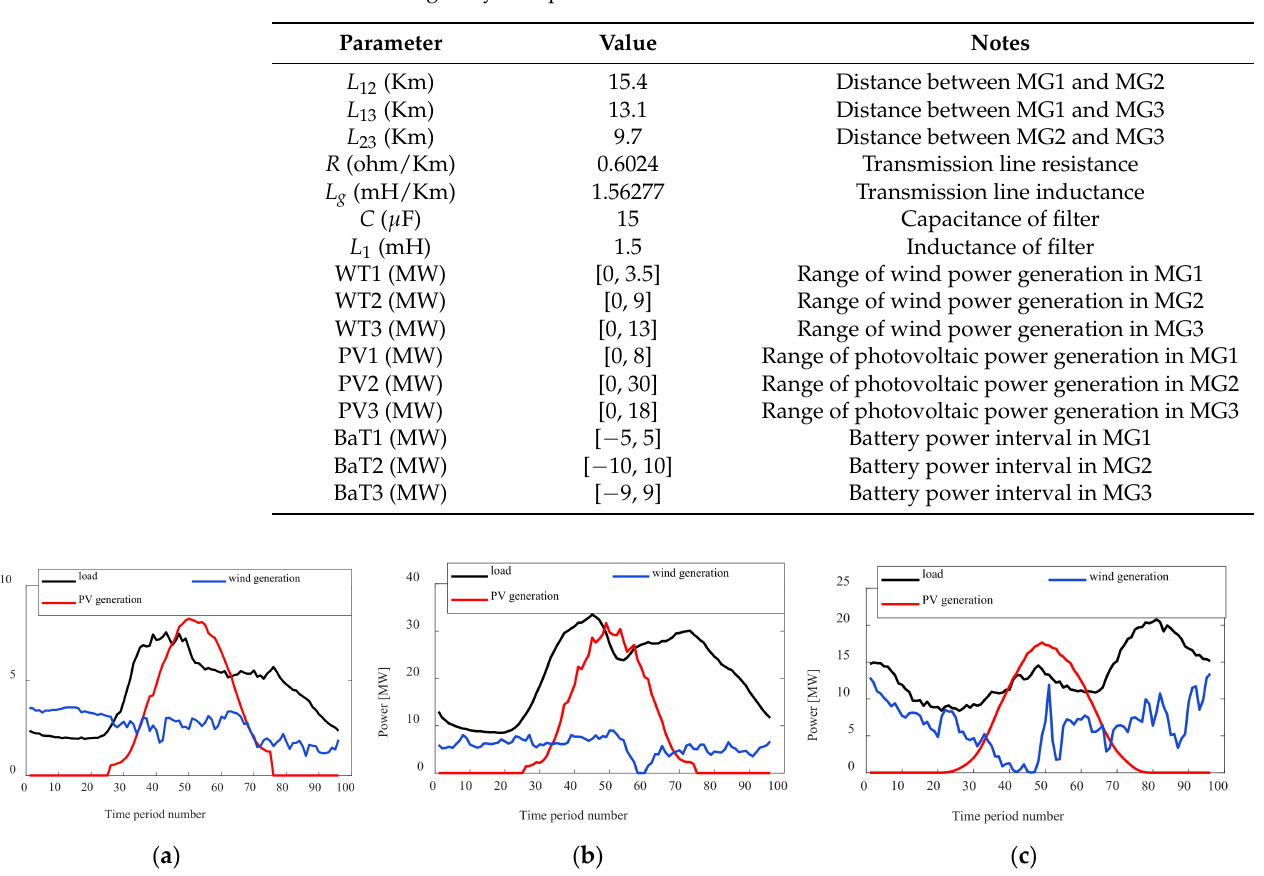
Table 2. Power grid system parameters.